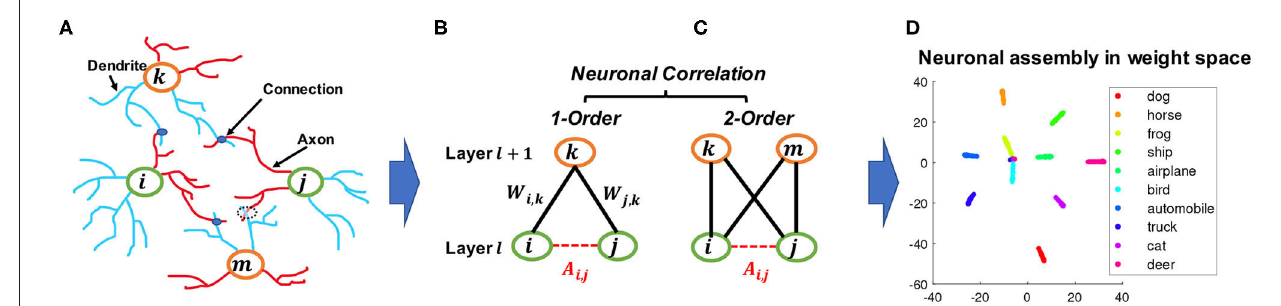
FIGURE 1 | An illustration of how the proposed constraint drew inspiration from BNNs and bipartite graphs. (A) neuron correlations in BNNs correspond to connections between dendrites, which are represented by blue lines, and axons, which are represented by red lines. (B,C) analogy of figure (A) represented as connections between layers in DNNs; although nodes i and j cannot form direct links, they can be correlated by a given node k as a first-order correlation, or by two nodes k and m as a second-order correlation which is also equivalent to a 4-cycle in bipartite graphs. (D) an example of a learned neuronal assembly in neurons outgoing weight space, with the dimensionality reduced to 2D with T-SNE (Maaten and Hinton, 2008). Each point represents one neuron and the neurons are colored according to their highest activated class in the test